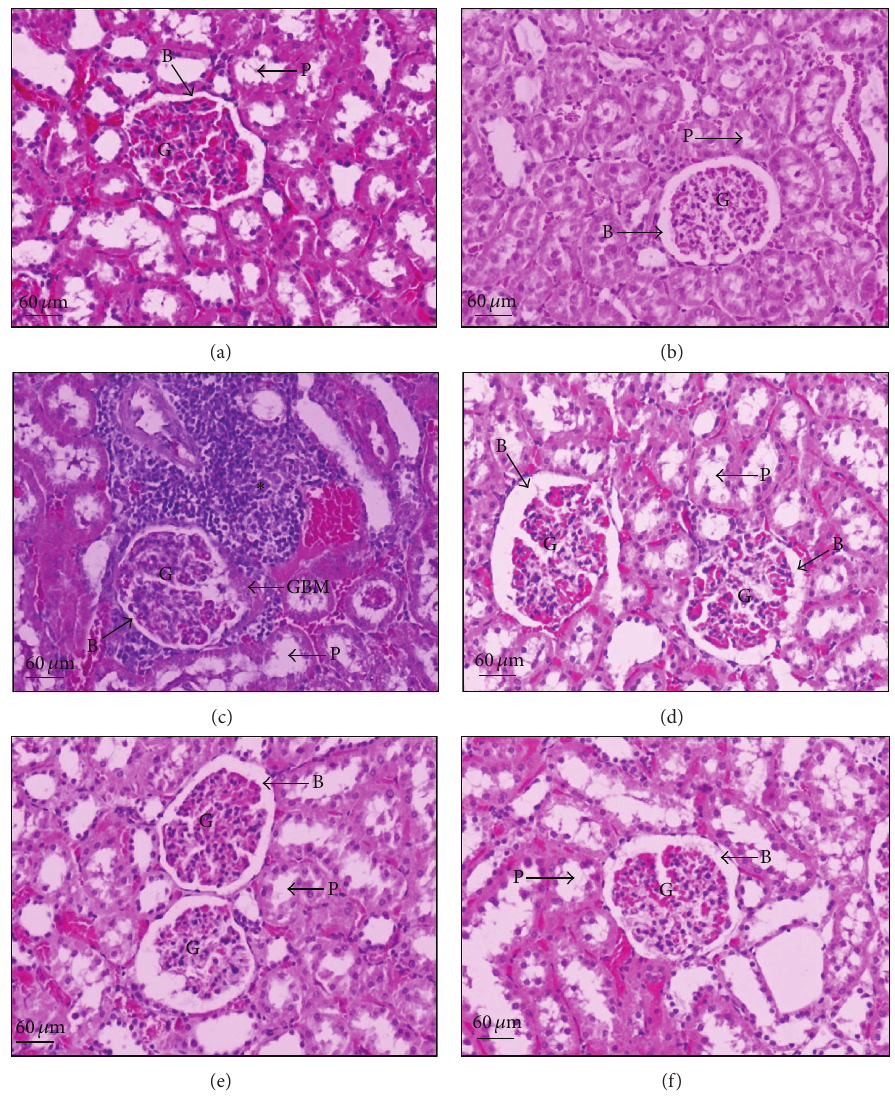
Figure 2: Micrographs of conventional Hematoxylin and Eosin (H&E) staining of rat kidneys. A sagittal half of kidney from each experimental group was removed, fixed, embedded, cut, and stained by H&E (original magnification 200x for all panels). The data were repeated at least 3 times from separate sets of animals. The results were analyzed using bright-field microscopy. (a) Normal (ND), (b) normal diet supplemented with CGE (ND + CGE), (c) T2DM (DM), (d) T2DM treated with metformin (DM + metformin), and ((e) and (f)) T2DM supplemented with CGE (DM + CGE). Arrow “B” in all panels indicates Bowman’s capsule space. Arrow labeled “P” indicates the proximal tubular epithelial cells and the tubular lumen space. Asterisk ( ∗ ) indicates infiltration of blood cells and lymphocytes. Glomerulus (G), proximal tubular epithelial cells and the tubular lumen space (P), and glomerular basement membrane